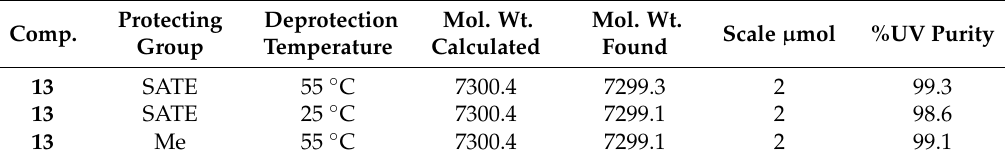
Table 1. Synthesis scale, deprotection condition and analytical data of guide strand 13 synthesized using t Bu-SATE vs. methyl protecting